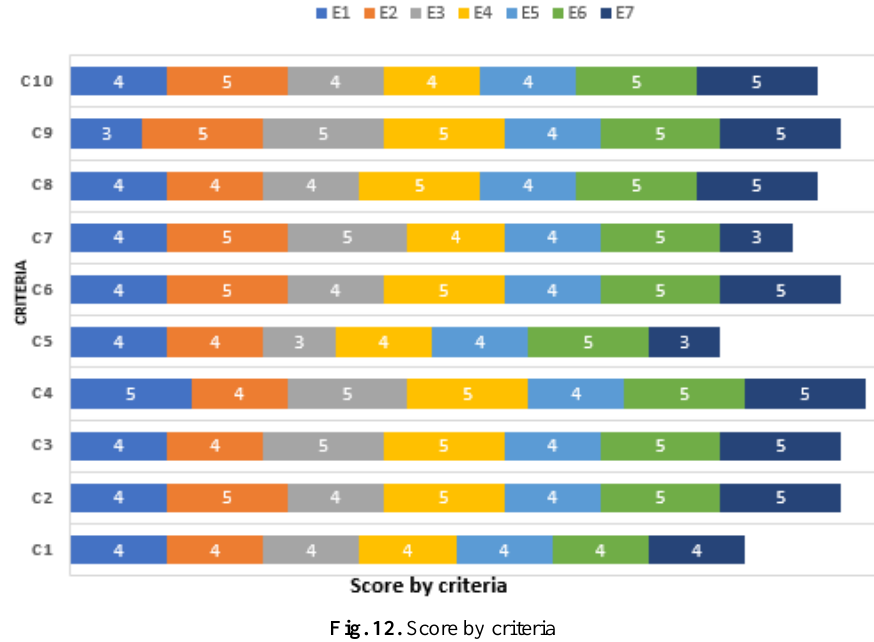
Fig. 12. Score by